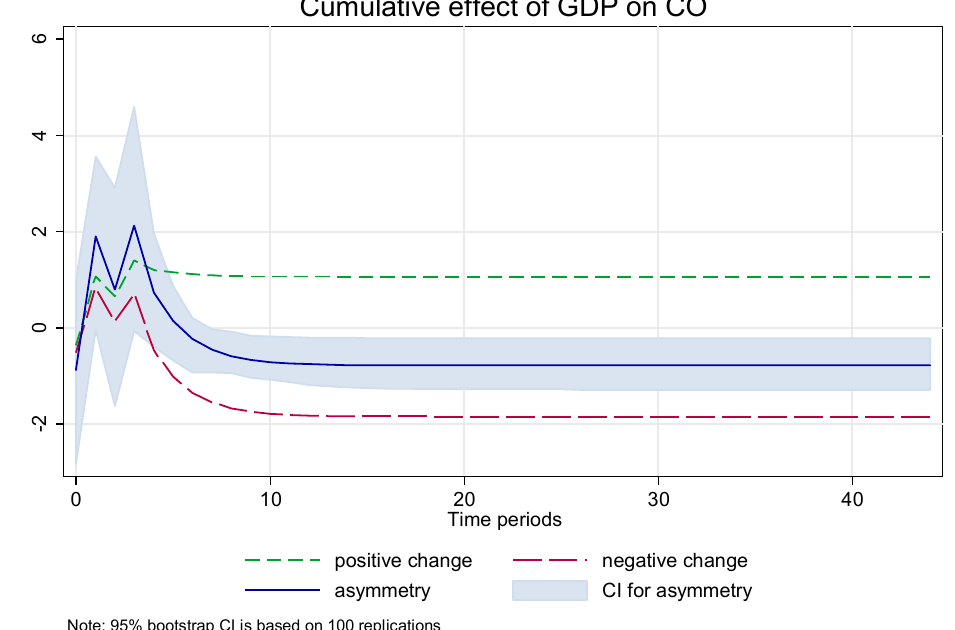
Figure A6. Cumulative effect of GDP on CO.